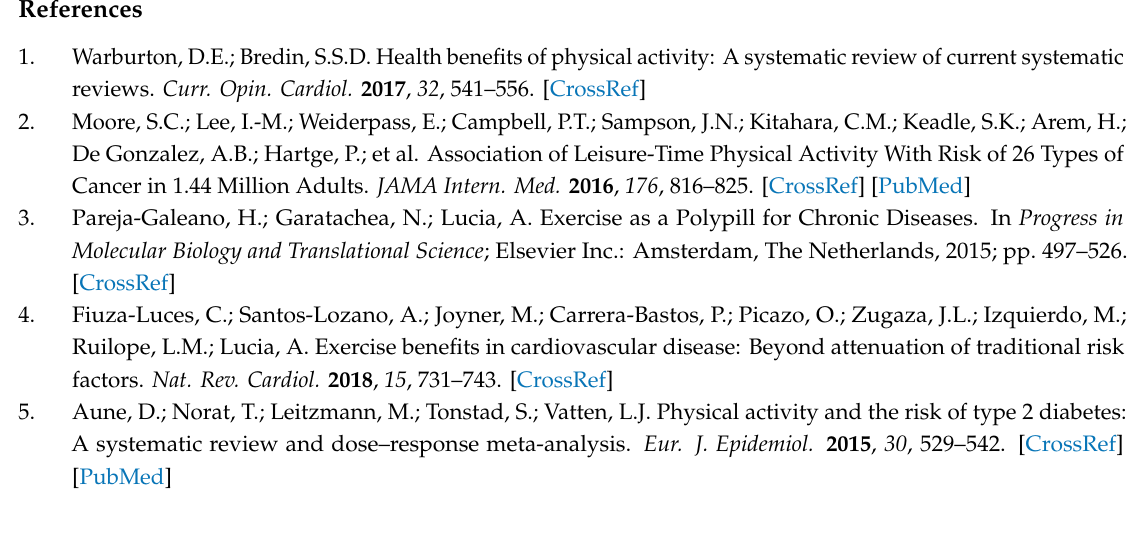
Table S1: Weekly activity levels of PA trajectories and of the total sample ( n = 197, complete PA data for baseline and